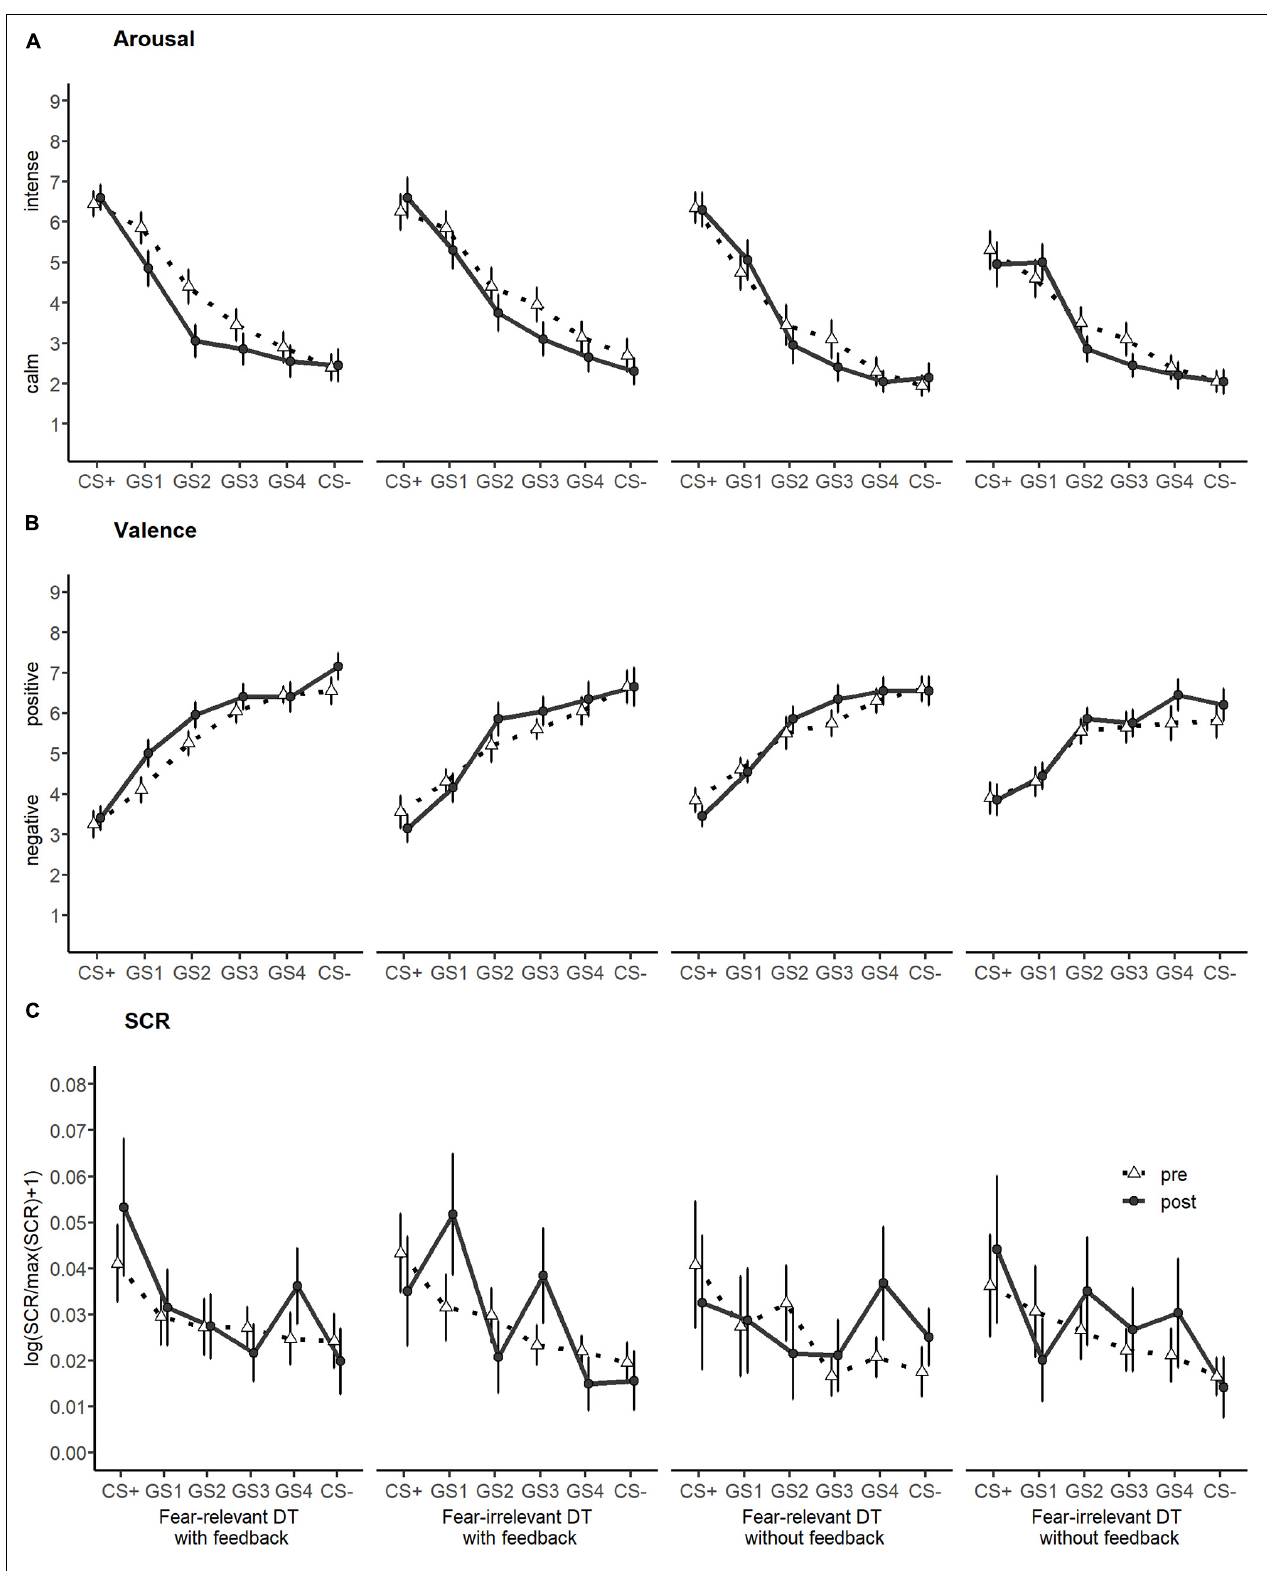
FIGURE 5 | Generalization gradients for arousal (A) and valence ratings (B) as well as skin conductance responses (C) separately for each training group and generalization pre- and post-training.